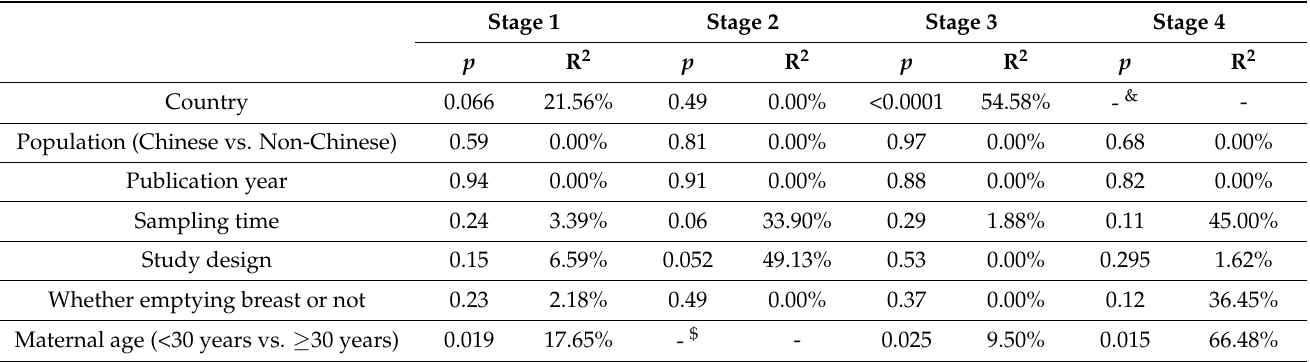
Table A1. Univariate Meta-regression of enrolled studies for heterogeneity